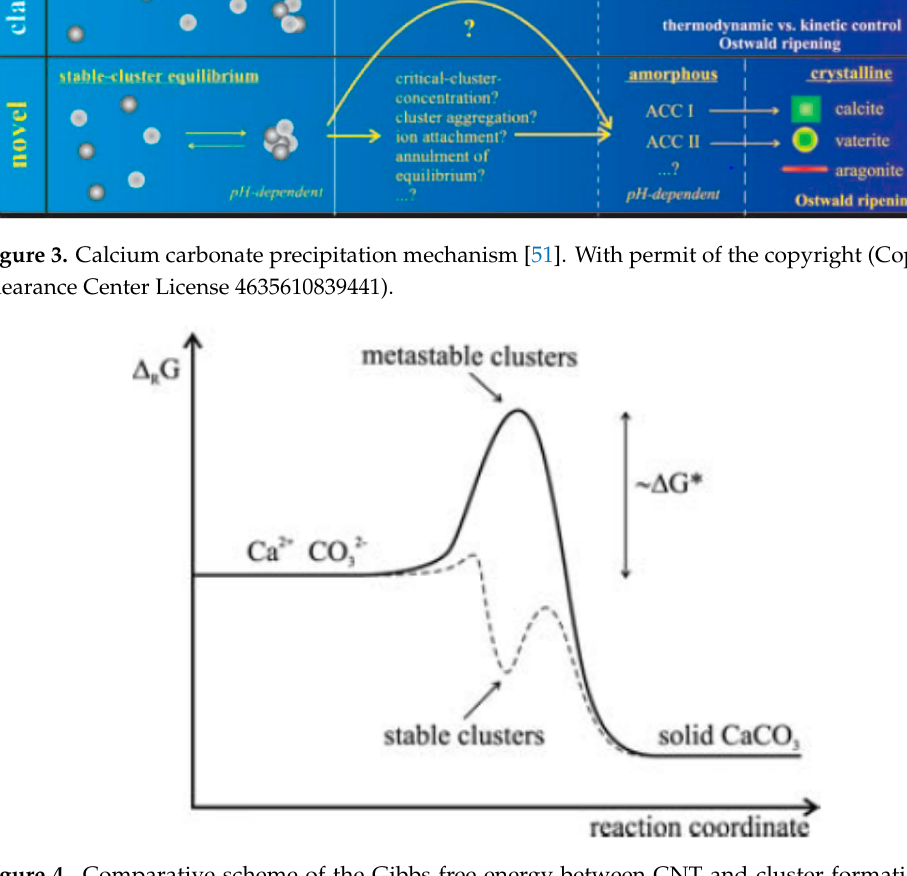
Figure 4. Comparative scheme of the Gibbs free energy between CNT and cluster formation [51]. With permit of the copyright (Copyright Clearance Center License 4635610839441).